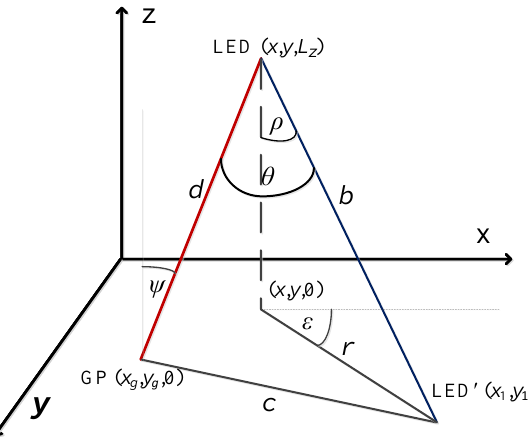
Figure 10. LED rotation